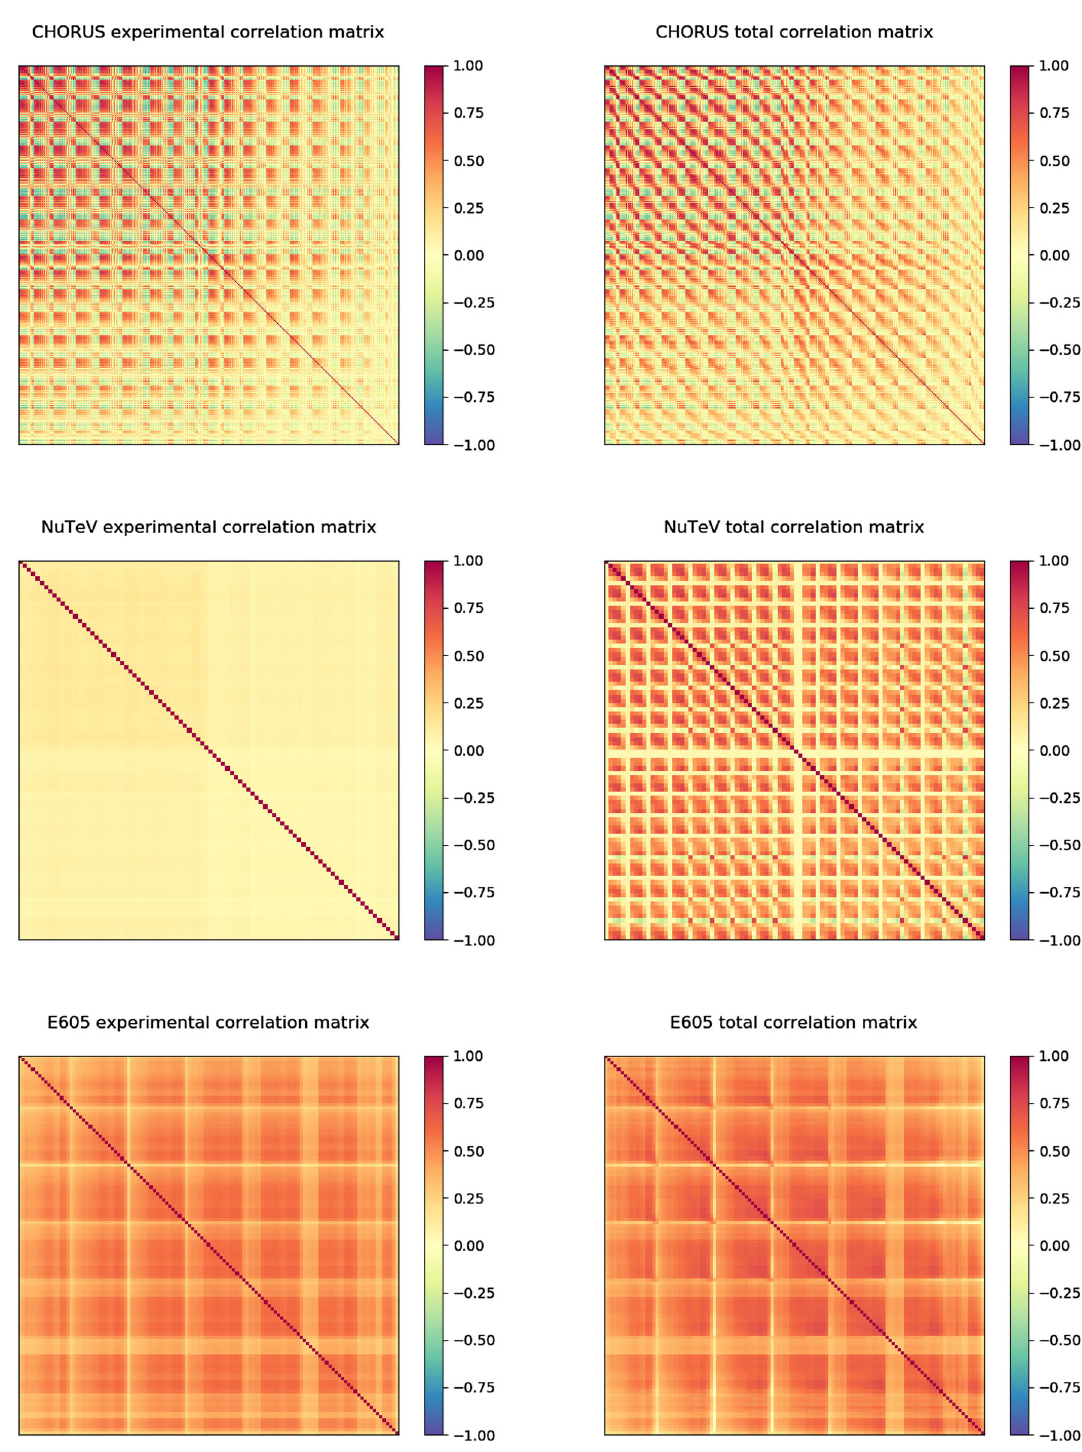
Fig. 8 The experimental (left) and total (right) correlation matrices for CHORUS, NuTeV and E605. The theoretical covariance matrix, added to the experimental covariance matrix to obtain the total covariance matrix, is computed according to Eq.